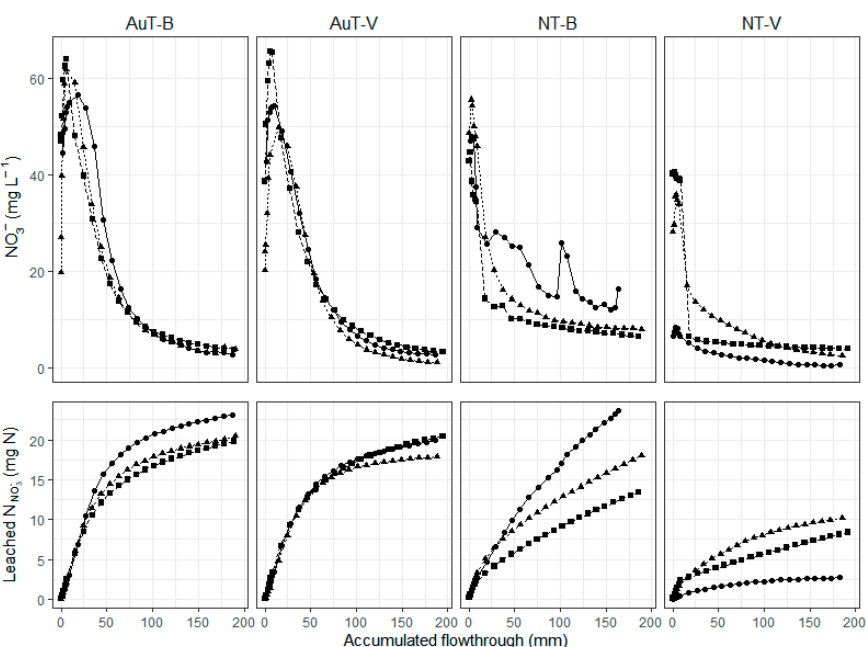
Figure 2. Nitrate concentration breakthrough ( top ) and accumulated leaching of NO 3 − N ( bottom ) curves from intact soil cores subjected to ~200 mm of simulated rain in a laboratory lysimiter. The cores belonged to two tillage treatments, no-till (NT) and autumn inversion tillage (AuT), as well as two cover crop treatments, bare fallow (B) and winter rye volunteers (V). Symbols indicate different field experiment blocks.